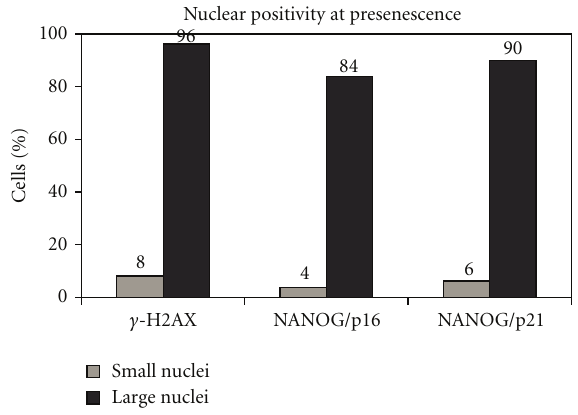
Figure 11: Proportions of the fibroblasts with enlarged (hyperte- traploidy) nuclei and with conventional small nuclei in the early presenescence stage, estimated in one of the samples by the labelling frequency for γ -H2AX ( n = 400 cells), NANOG/p16 positive ( n = 300 cells), and NANOG/p21-positive nuclear granules ( n = 300 cells). All nuclear labels were mostly present in this phase in the perinucleolar region. Evaluation reveals a many-fold prevailing sig- nalling for DDR, self-renewal, and senescence regulators occurring simultaneously in the enlarged hypertetraploidy cells, which left normal cell